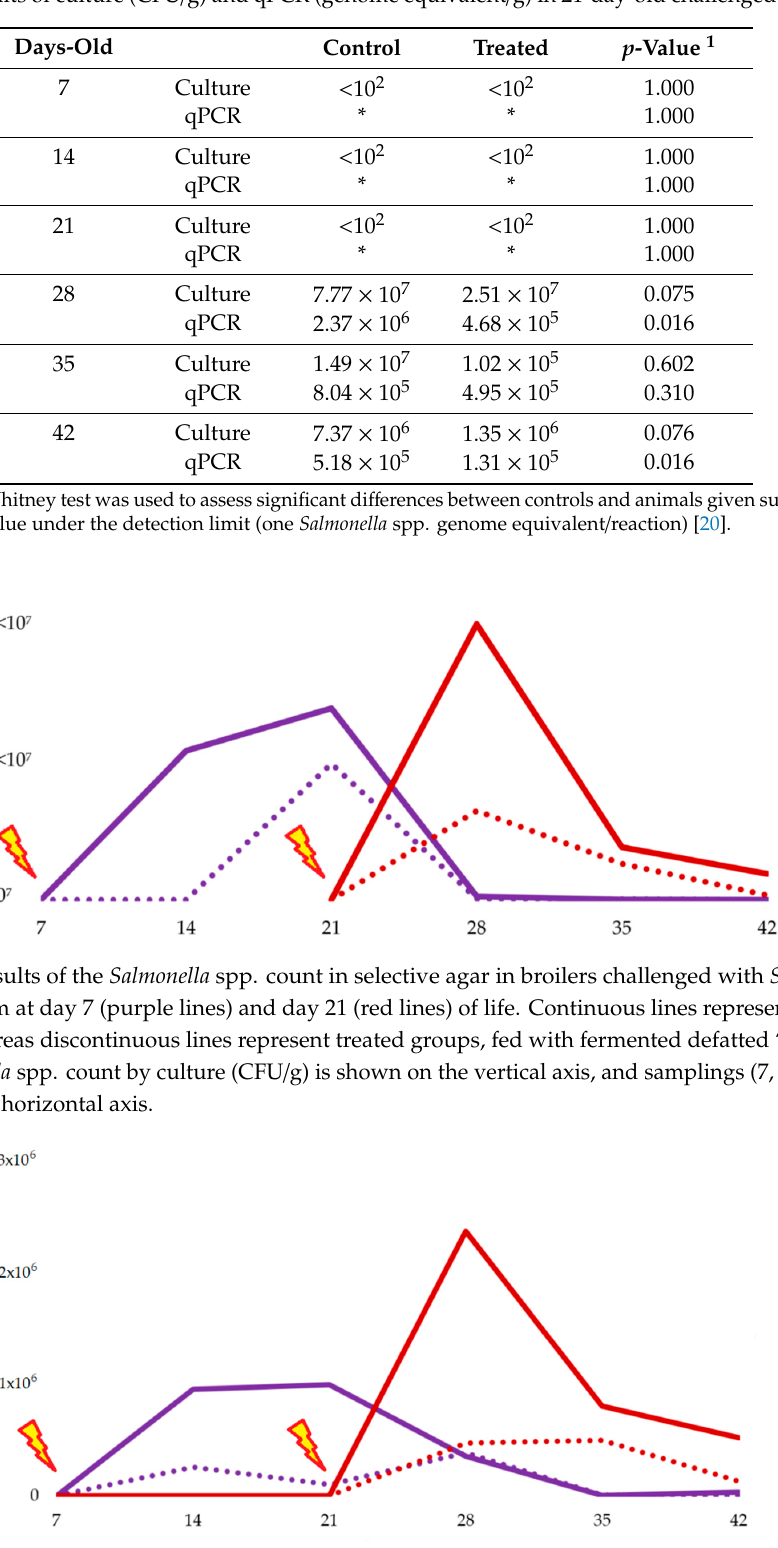
Figure 2. Results of the qPCR for Salmonella spp. in broilers challenged with Salmonella Typhimurium at day 7 (purple lines) and day 21 (red lines) of life. Continuous lines represent control groups, whereas discontinuous lines represent treated groups, fed with fermented defatted ‘alperujo’. The genome equivalent/g is shown on the vertical axis, and samplings (7, 14, 21, 35, or 42) on the horizontal axis.